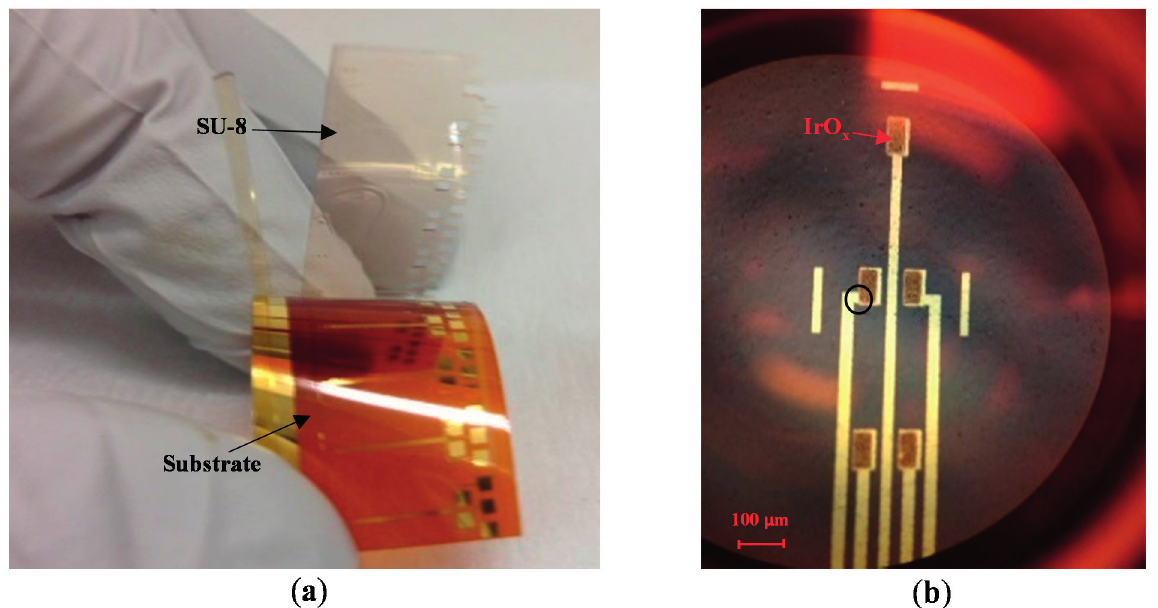
Figure 2. ( a ) Photo of the peeled-off SU-8 mask layer after the first heat treatment; ( b ) A photo of the MEA with the sensing areas coated with IrO x . The sensing film size of each electrode was 50 × 100 µm 2 . The black circle on the top-right electrode of the MEA indicates the area imaged by a scanning electron microscopy in Figure